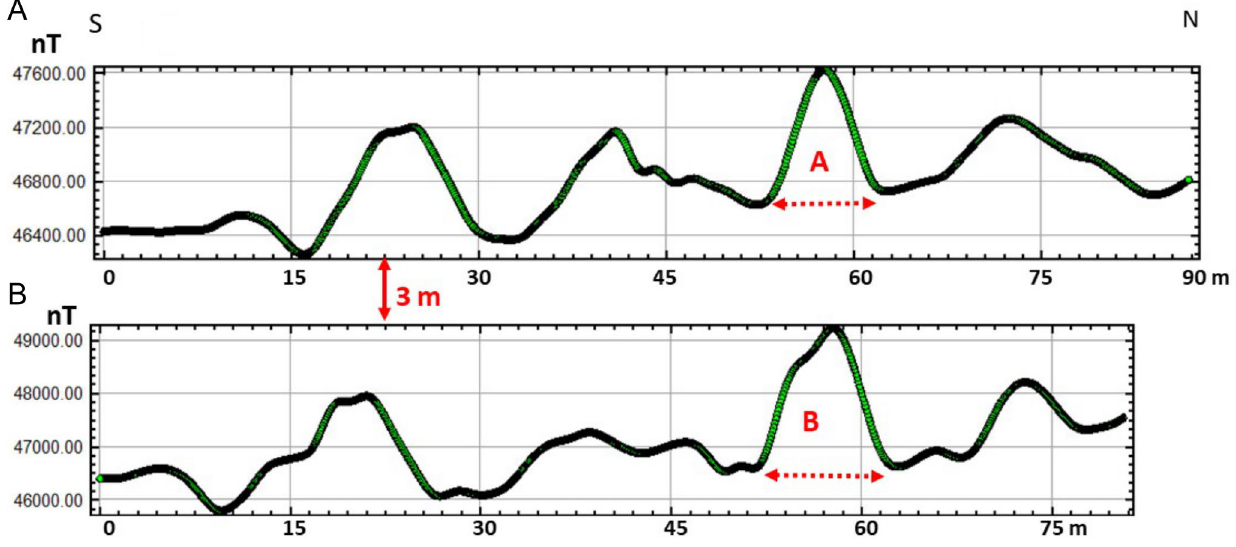
Figure 10: Magnetic data on profiles P6 [A] and P7 [B]. Note that the two data sets are quite correlative and indicate a high magnetic anomaly ( A and B ) are at about the same